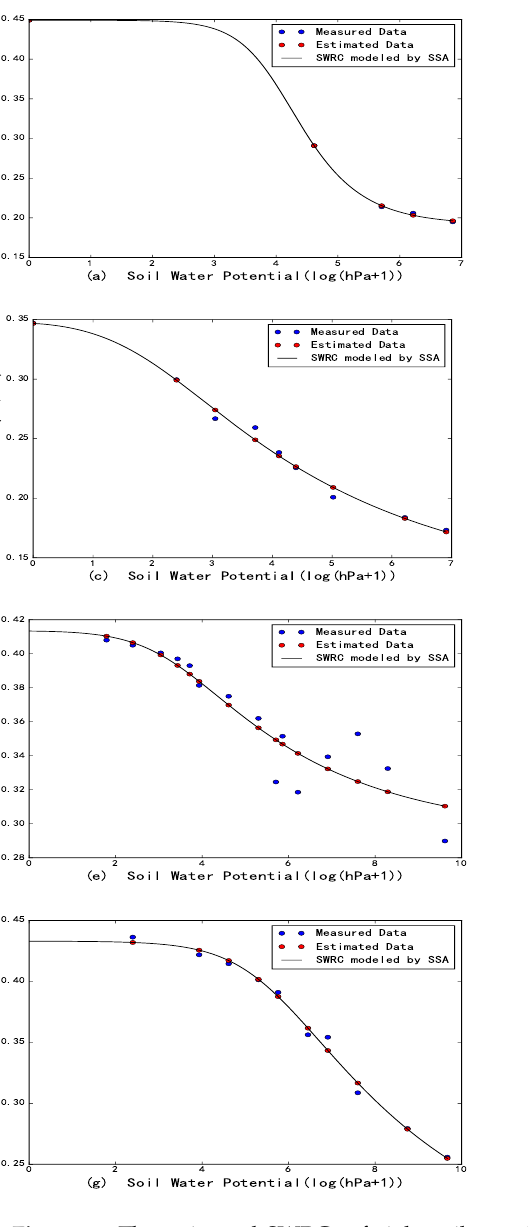
Figure 2. The estimated SWRCs of eight soil samples using SSA. ( a ) Sample 3020, ( b ) Sample 1120, ( c ) Sample 1102, ( d ) Sample 1330, ( e ) Sample 1162, ( f ) Sample 2400, ( g ) Sample 1361, and ( h ) Sample